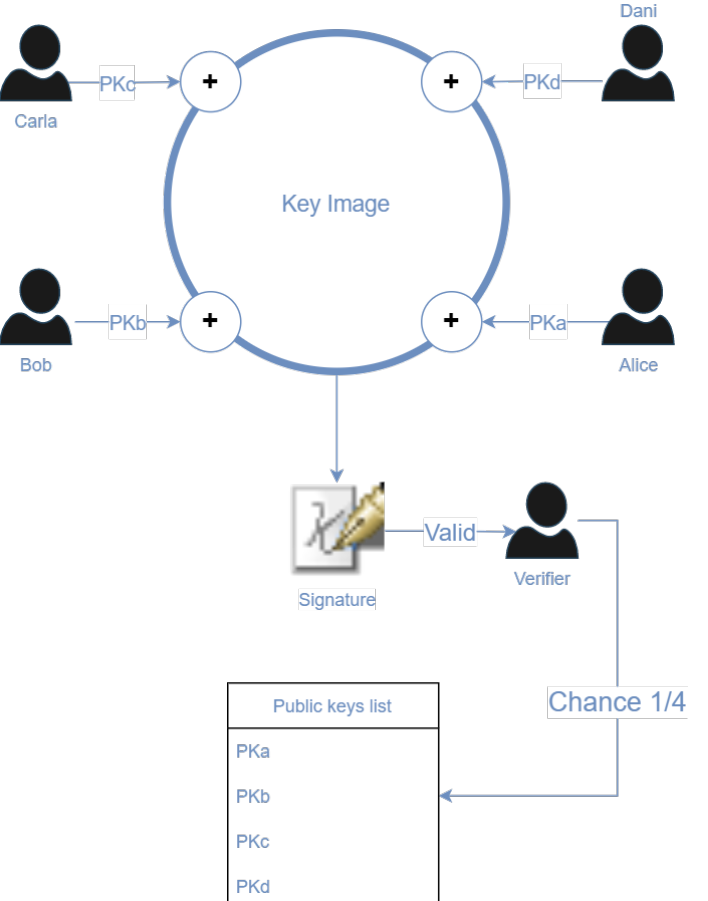
Figure 4. Key image, created from a list of the signatures of the users Bob, Alice, Carla, and